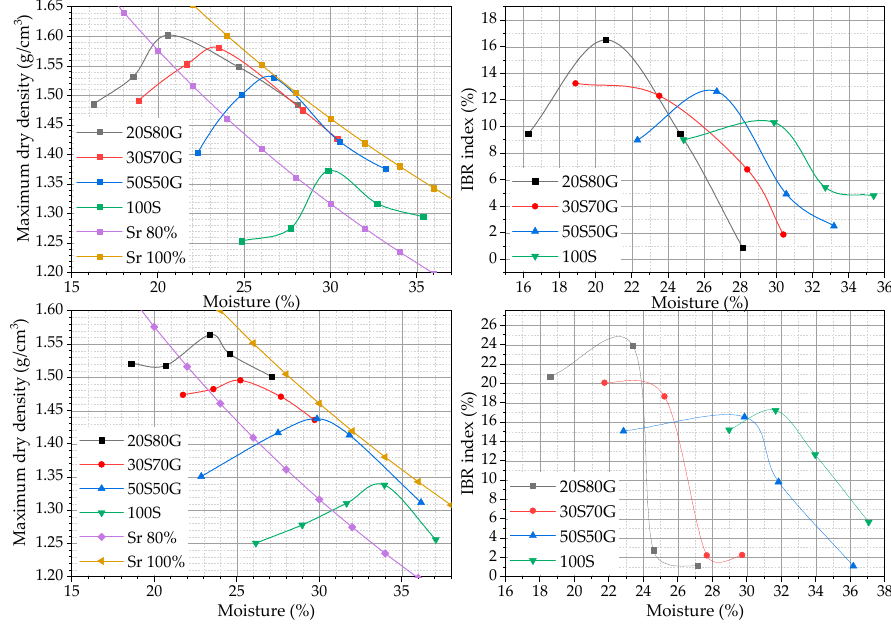
Figure 4. Mix IBR indexes: ( a ) non-treated and ( b ) treated. Table 5. Designed materials for recycling sediments and granular addition .